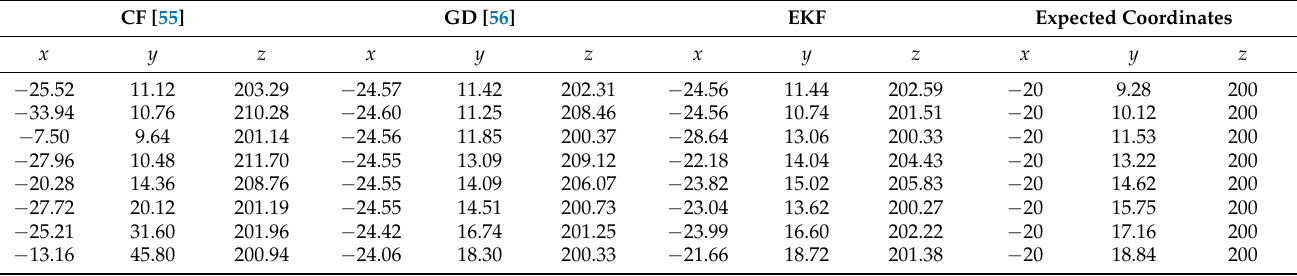
Table 4. Motion state attitude angle error after the fusion of three kinds of filtering (unit